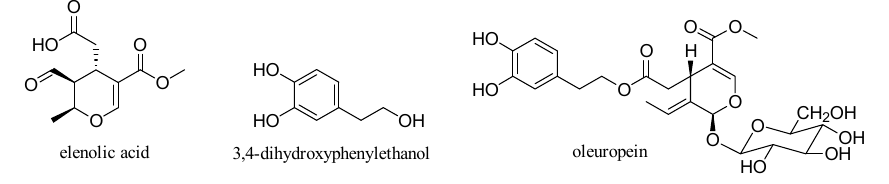
Figure 15. Structure of oleuropein .